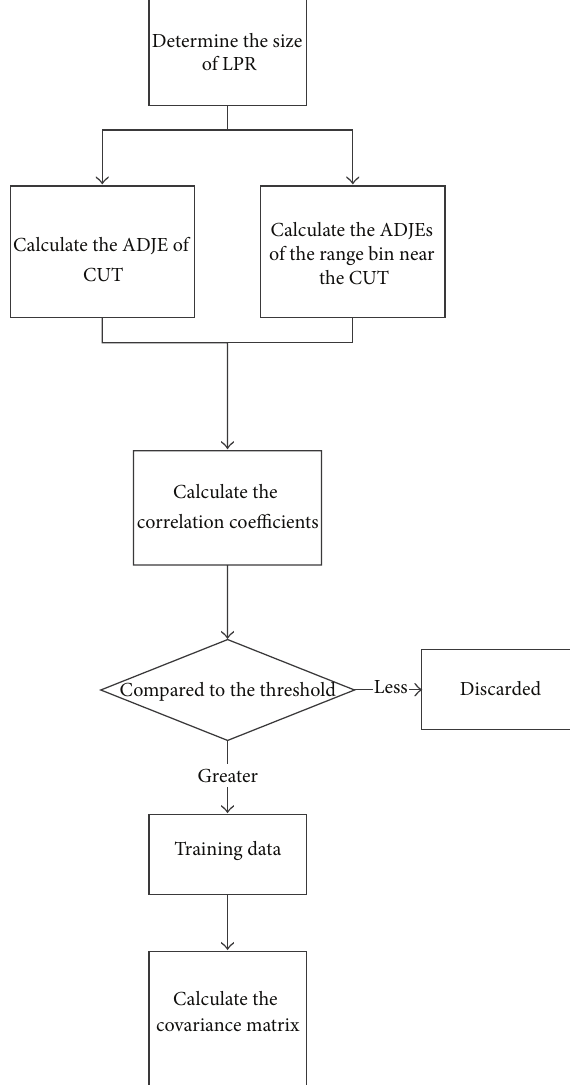
Figure 9: Implementation of